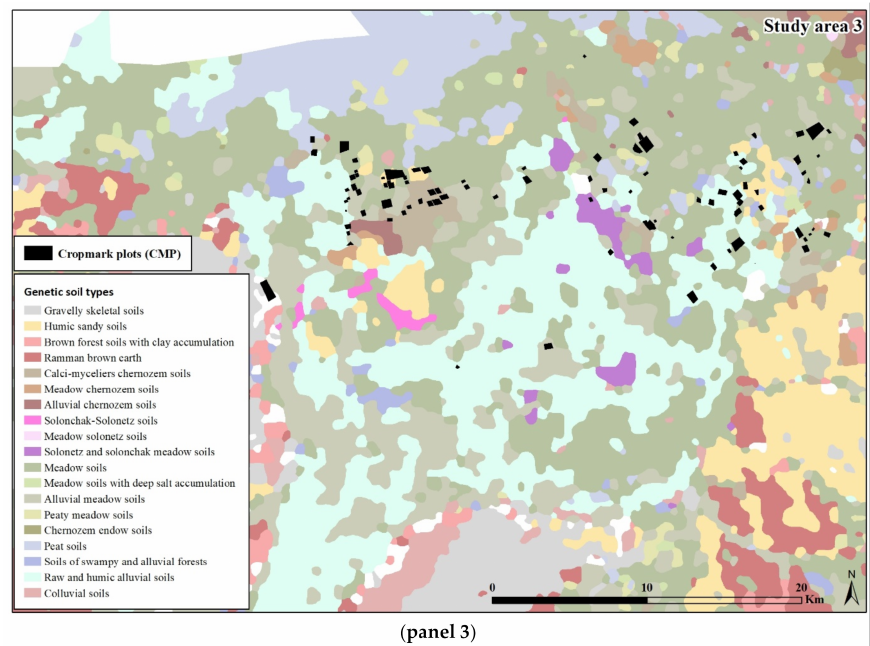
Figure 4. ( panel 1–3 ). Distribution of CMPs on the soil type map for the study